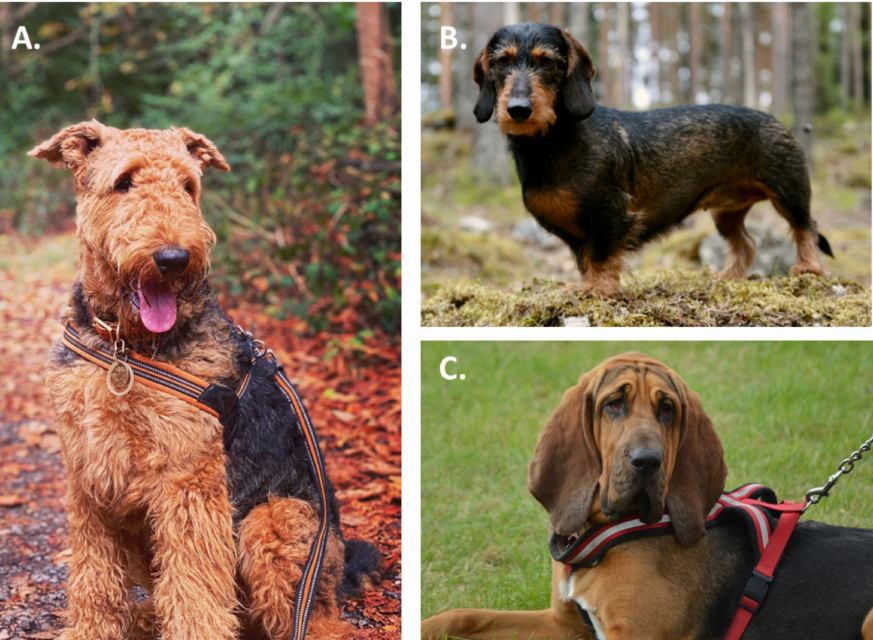
Figure 1. Typical representatives of boarhounds: ( A ) terrier: Welsh Terrier belongs to group III Section 1 large and medium sized terriers; ( B ) dachshund: Wire-haired Dachshund belongs to group IV dachshunds; ( C ) hounds: Bloodhound belongs to group VI Section 1 scent